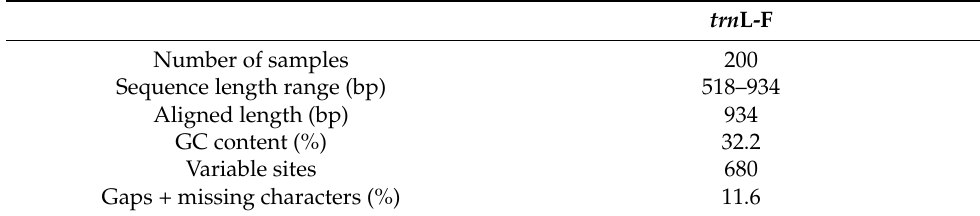
Table 3. Descriptive statistics for trn L-F